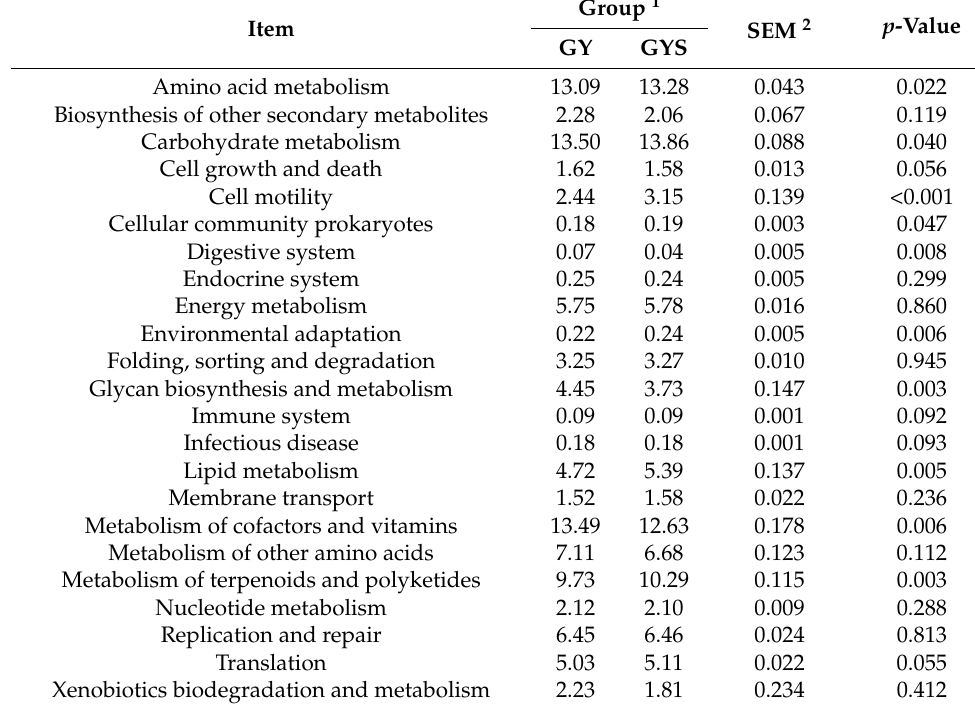
Table 4. Effect of concentrate supplementation on predict functions in the bacterial community of grazing yaks during the warm season.